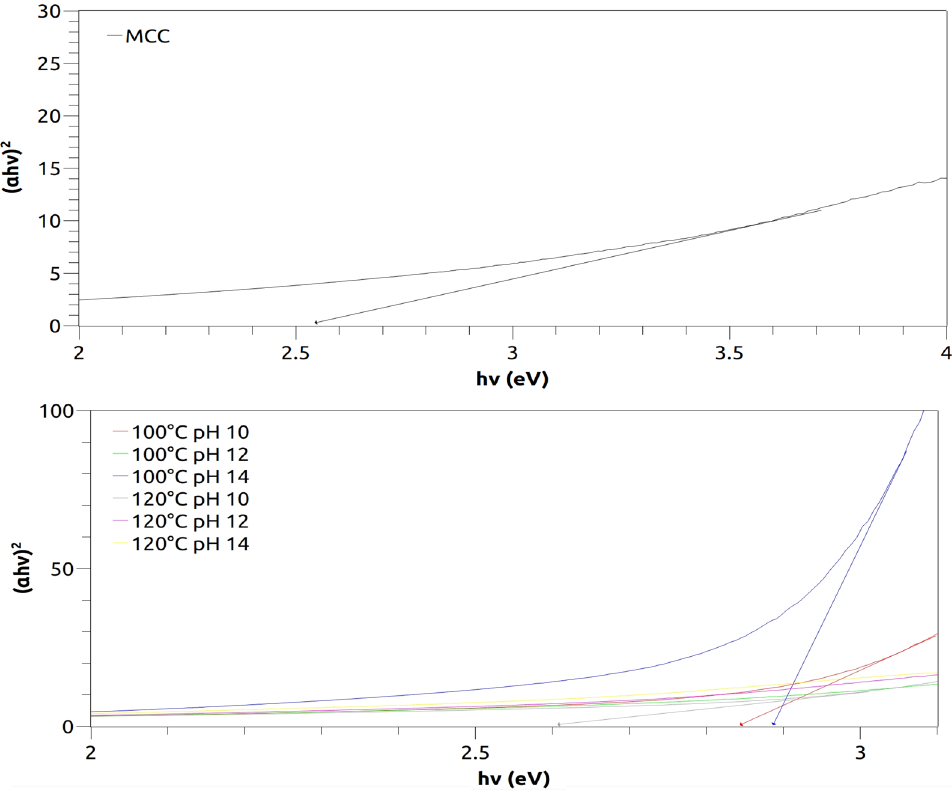
Figure 4. UV–Vis spectra of the microcrystalline cellulose (upper) and the hybrid nanostructures composed of CeO